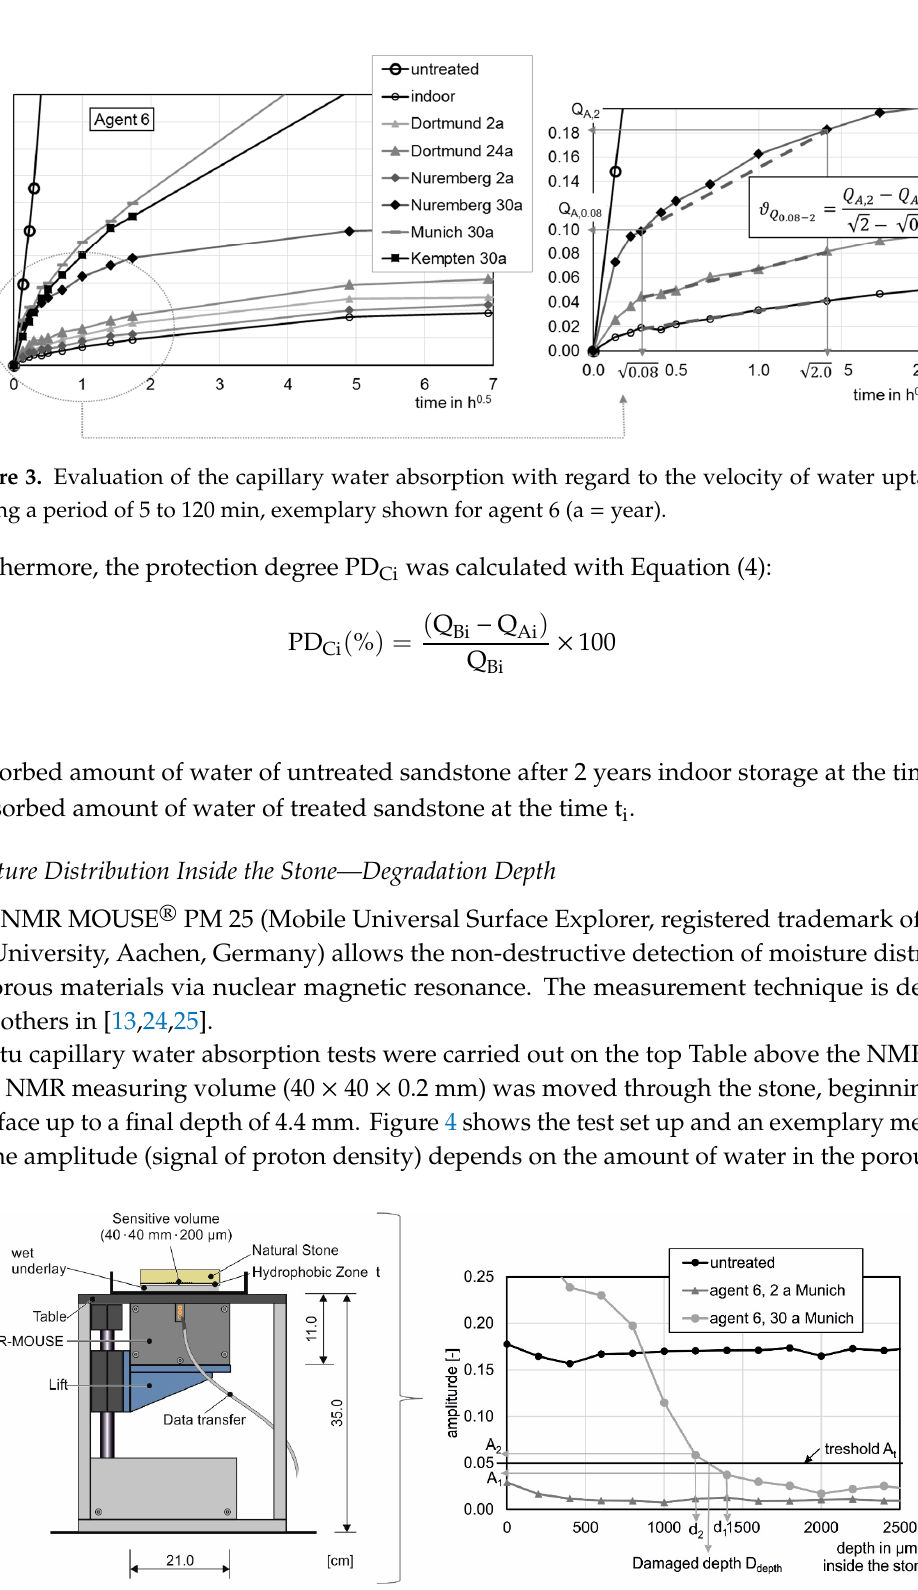
Figure 4. Test set up of in situ NMR measurements during capillary water absorption and determination of the depth of damage after 30 years of outdoor weathering in Munich, shown as an example with protective agent 6.